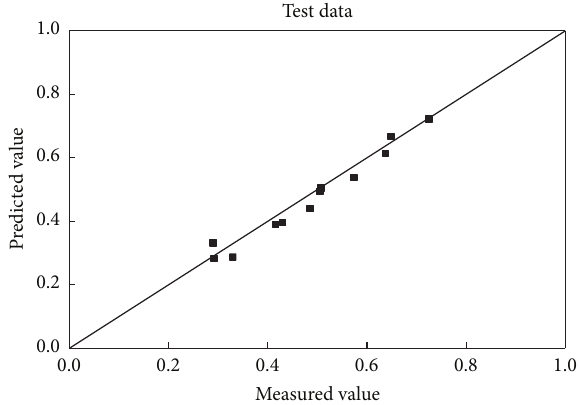
Figure 7: Comparison of the predicted and measured wall factors of rectangular prisms for the test data.